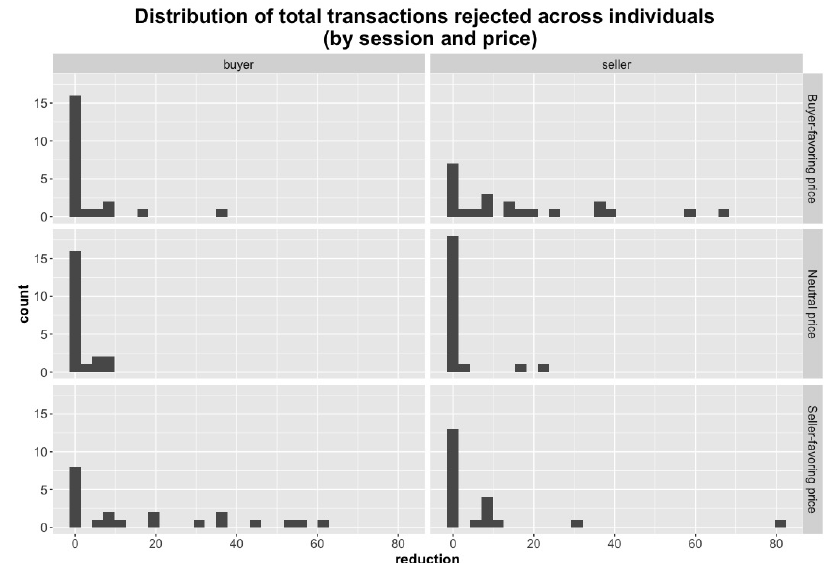
Figure 1. Each plot shows the observed distribution of “reductions from full trade” expressed by participants of a given type in a given treatment over all rounds combined.